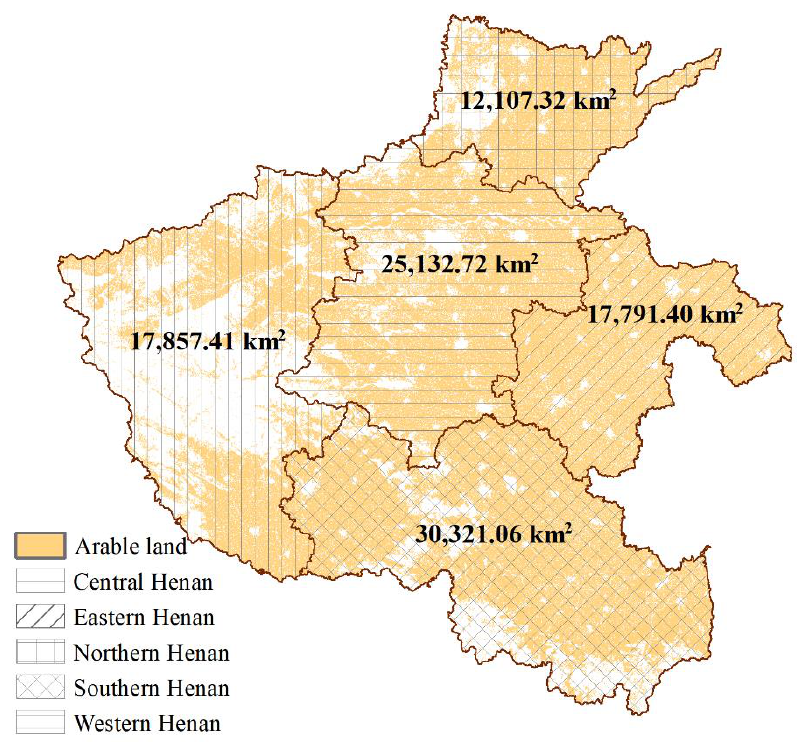
Figure 5. Corrected moderate farming scale.